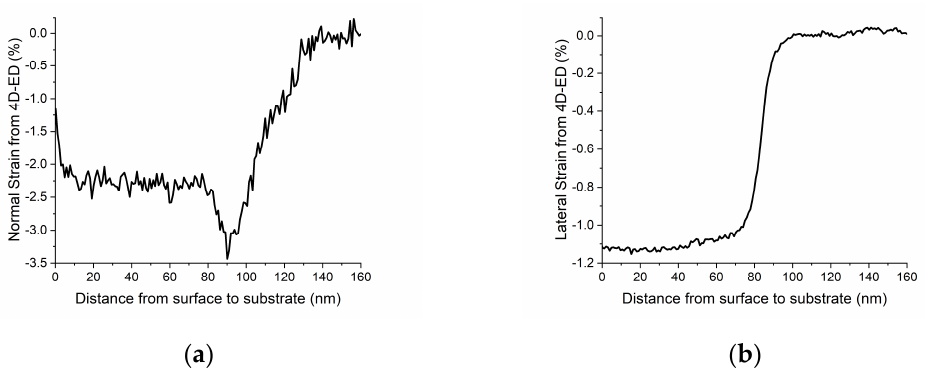
Figure 5. One-dimensional strain distribution in an Si:B sample as a function of depth. ( a ) Normal component. ( b ) Lateral component.